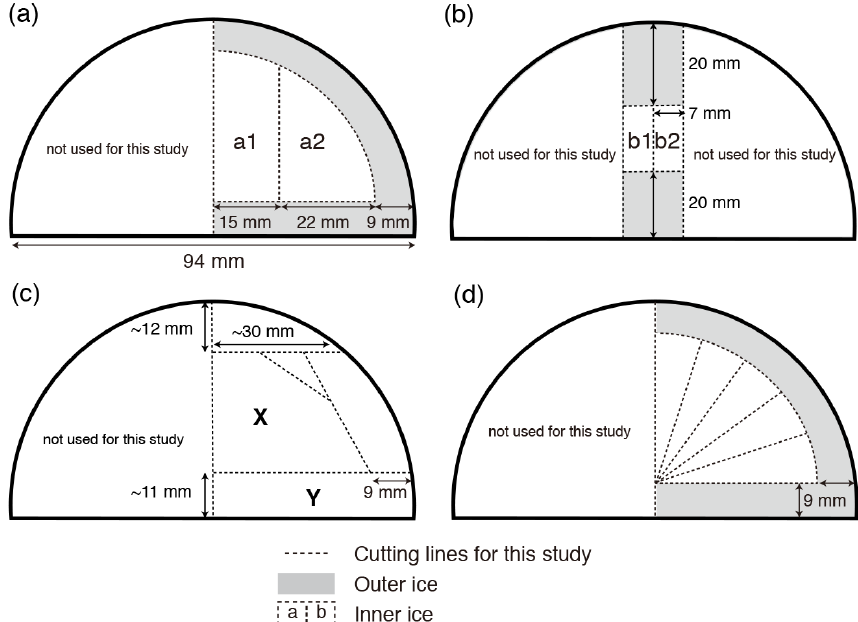
Figure 1. Typical cross-sectional cutting plan. The outer black line in each panel is the original surface that was exposed to the atmosphere for ∼ 20 years at − 50 ◦ C. Dotted lines are the cutting lines for this study. (a) Duplicate measurements and outer–inner comparisons. The sample length is 11cm. For single (non-duplicate) measurements, only a2 is cut out. (b) Same as panel (a) but for 13 depths in 1000–1100m with the sample length of 20cm. (c) High-resolution analysis. Sections X and Y were used for the gas and ion measurements with the lengths of 2.5 and 1.25cm, respectively, for X and Y , respectively. (d) Test of gas loss under vacuum with the length of